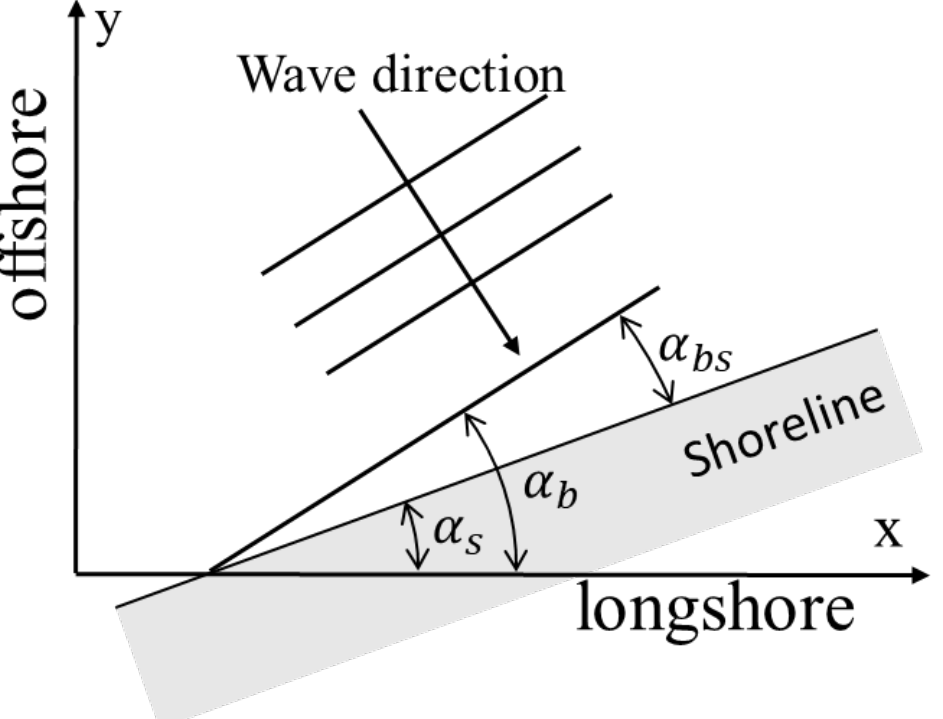
Figure 4. The schematic diagram for different angles used in this study.